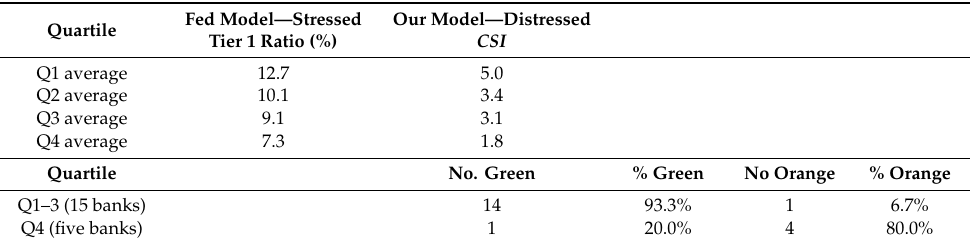
Table 4. Quartile statistics for 20 US banks (five banks per